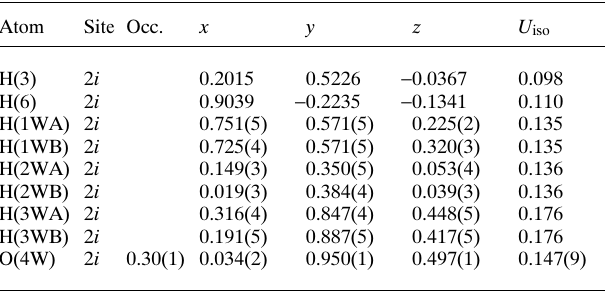
Table 2. Atomic coordinates and displacement parameters (in Å 2 ) . Atom Site Occ.